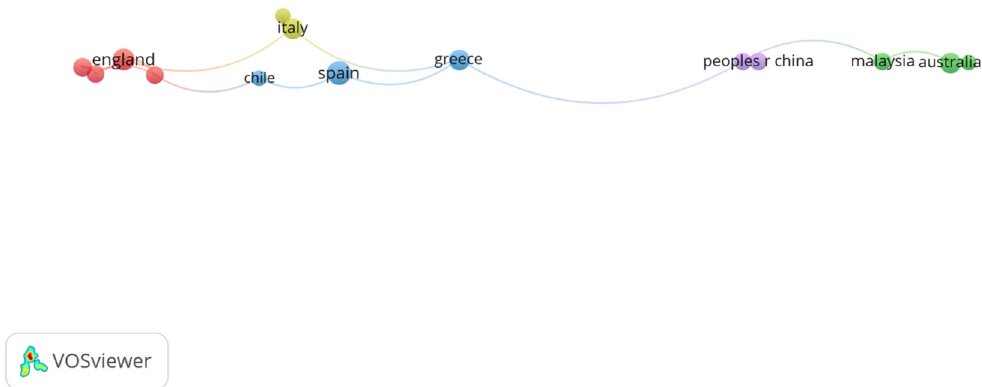
Figure 5. Country clusters. Figure 5. Country